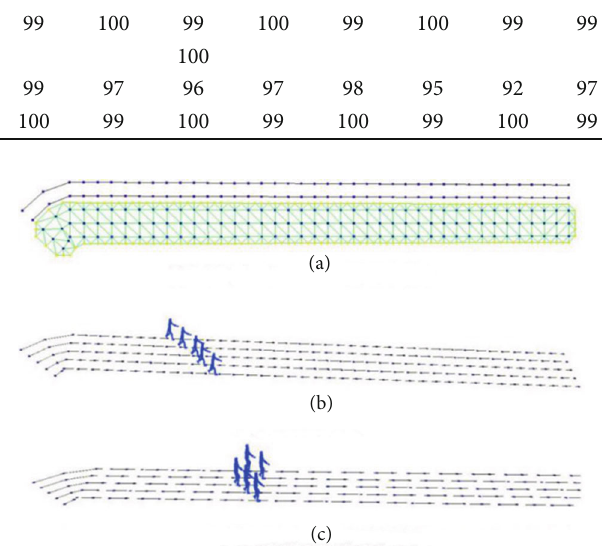
Figure 14: E ff ect of temporal track editing: (a) temporal track editing of three characters in the crowd: (b) the original formation of the crowd; (c) editing result.